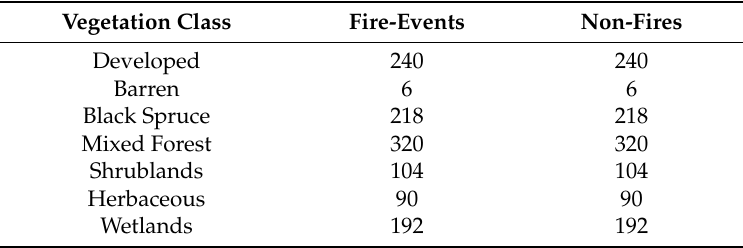
Table 1. Vegetation class and corresponding number of fire-events and random points